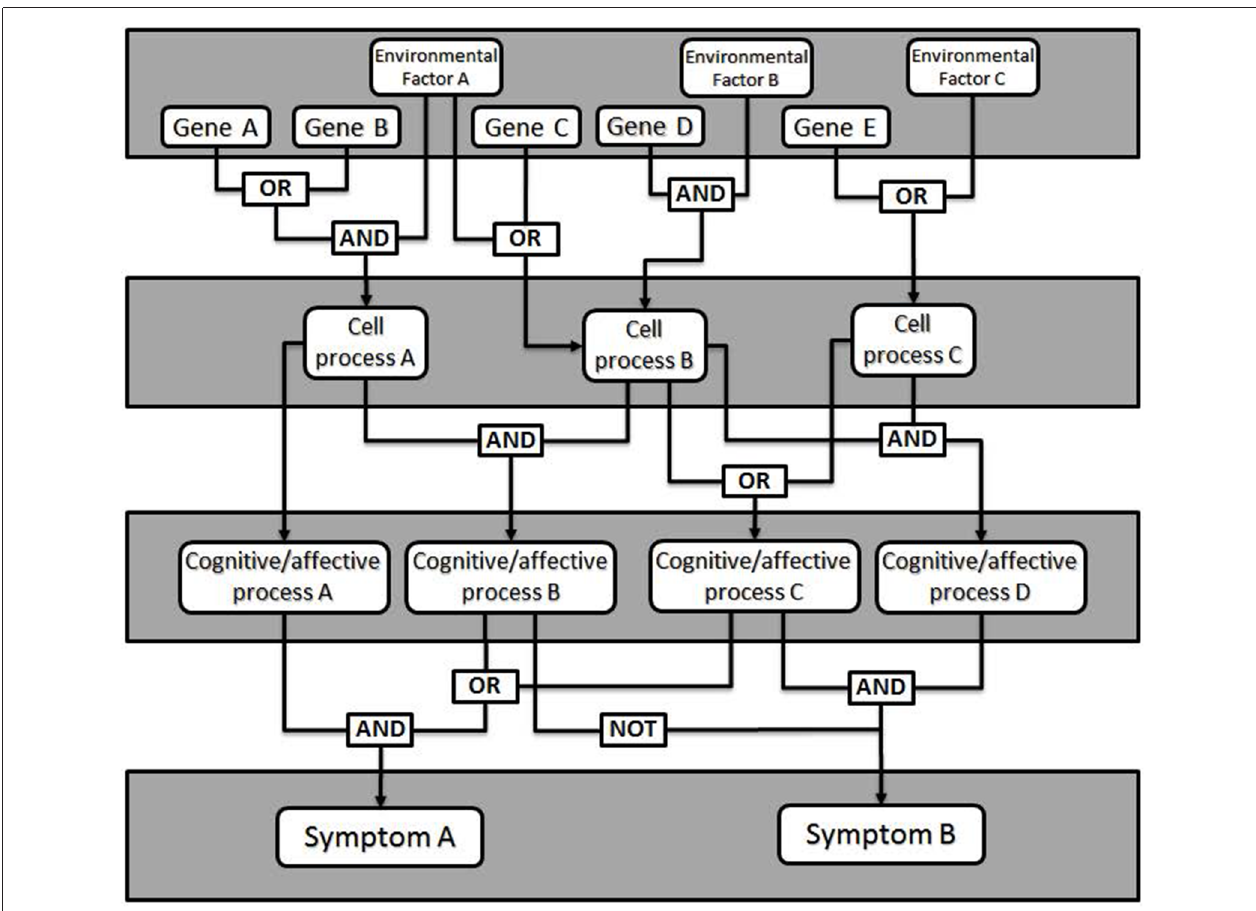
FIGURE 1 | General model of a fault tree. Gene expression changes combine with environmental factors (e.g., stress, brain injury) to affect cellular level processes (e.g., synaptic plasticity, neurotransmitter release). Logical combinations of alterations in cellular level processes produce changes in particular cognitive or affective processes (e.g., working memory, mood), which manifest as clinical signs or symptoms. Additional logic combinations (e.g., critical mass: any 4 of 7, etc.) can also be